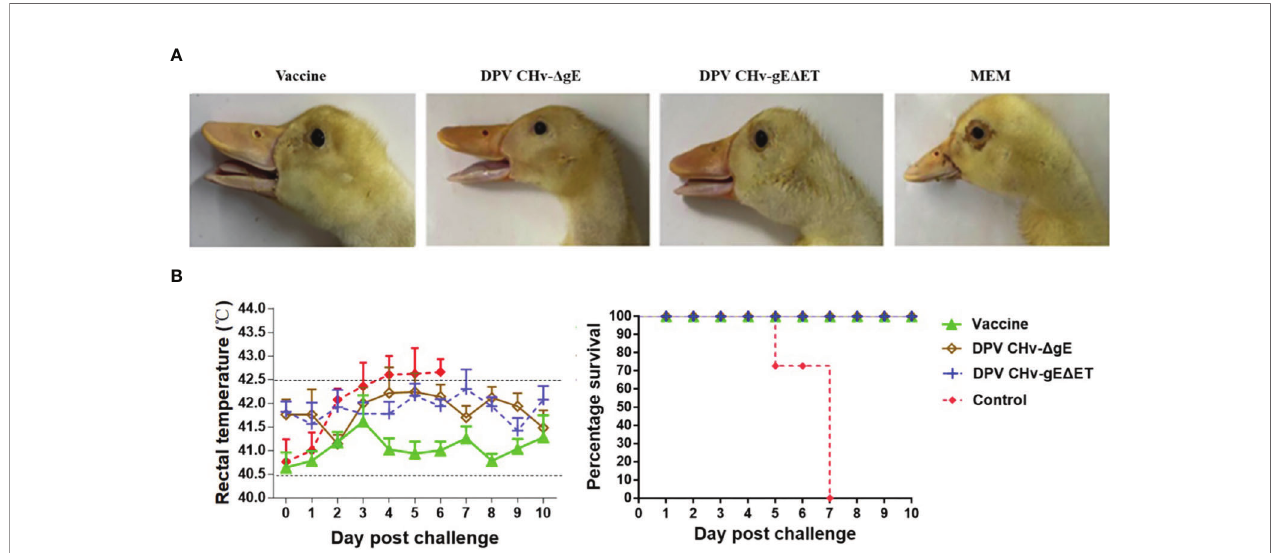
FIGURE 7 | The ducklings were challenged after immunization, and the clinical symptoms of the ducklings after the challenge were observed. (A) Eyelid condition. (B) Rectal temperature (left) and survival rate